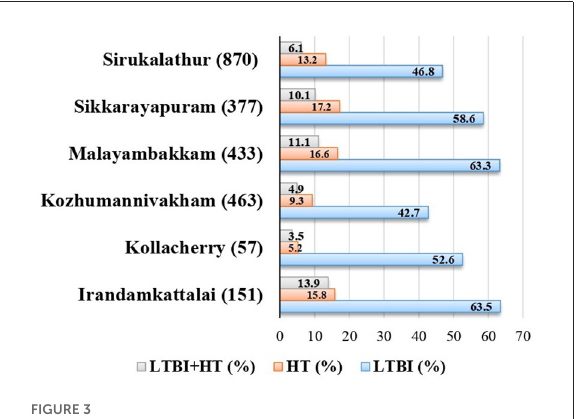
FIGURE3 Prevalence of LTBI and HTN village wise. LTBI, latent tuberculosis infection; HTN,